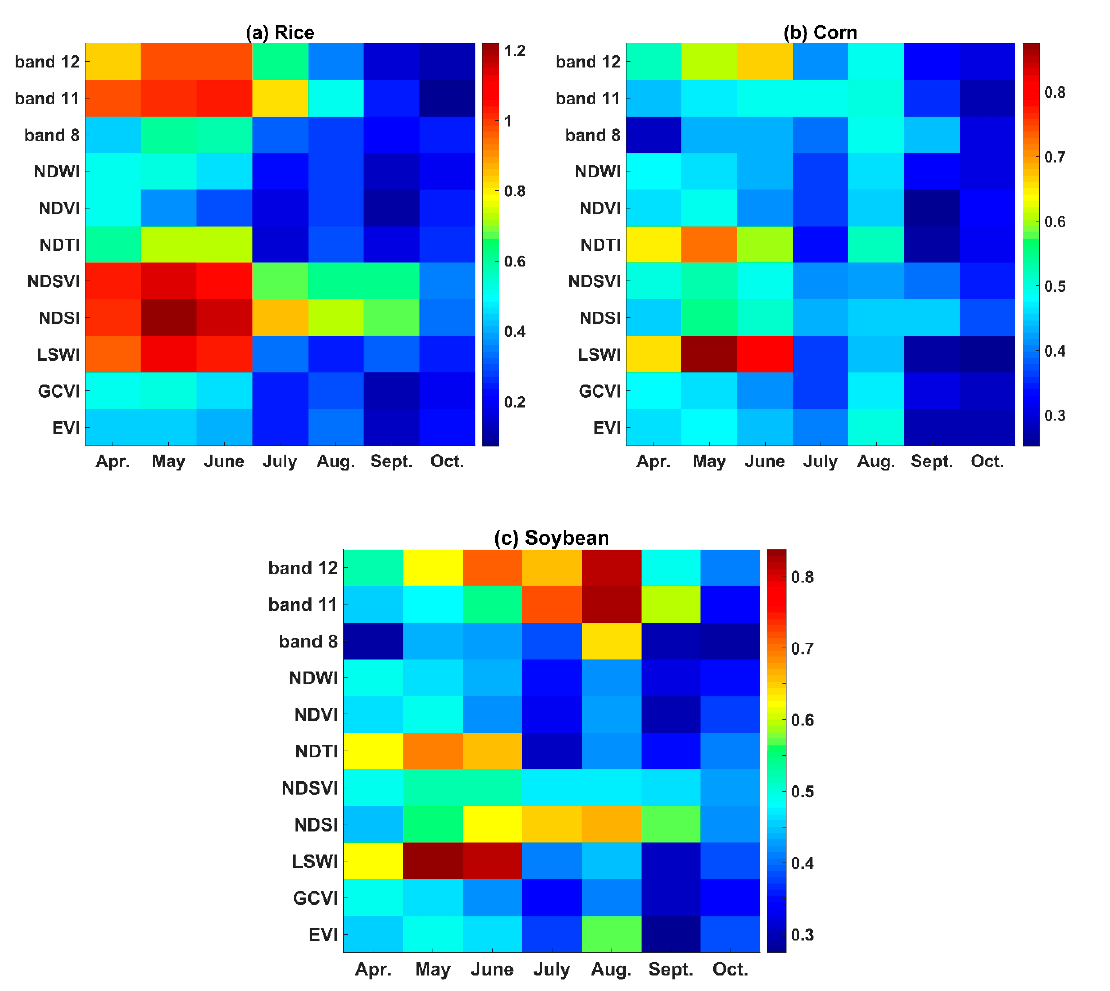
Figure 5. SI global pattern for identifying rice alone ( a ), corn alone ( b ), and soybean alone ( c ).